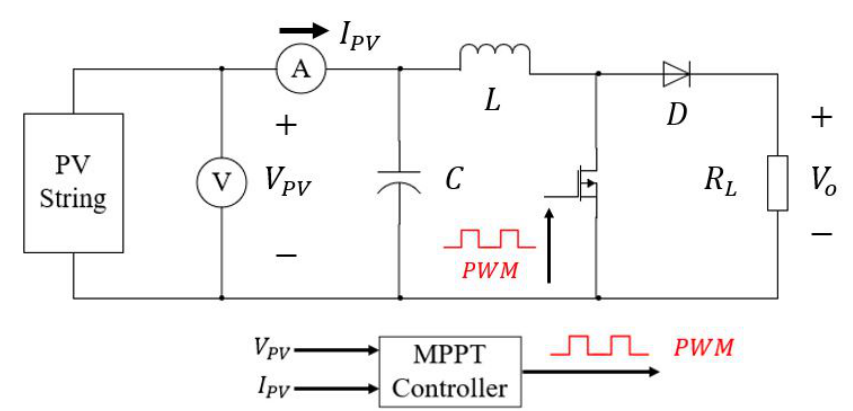
Figure 5. Basic PV system with the DC-DC boost